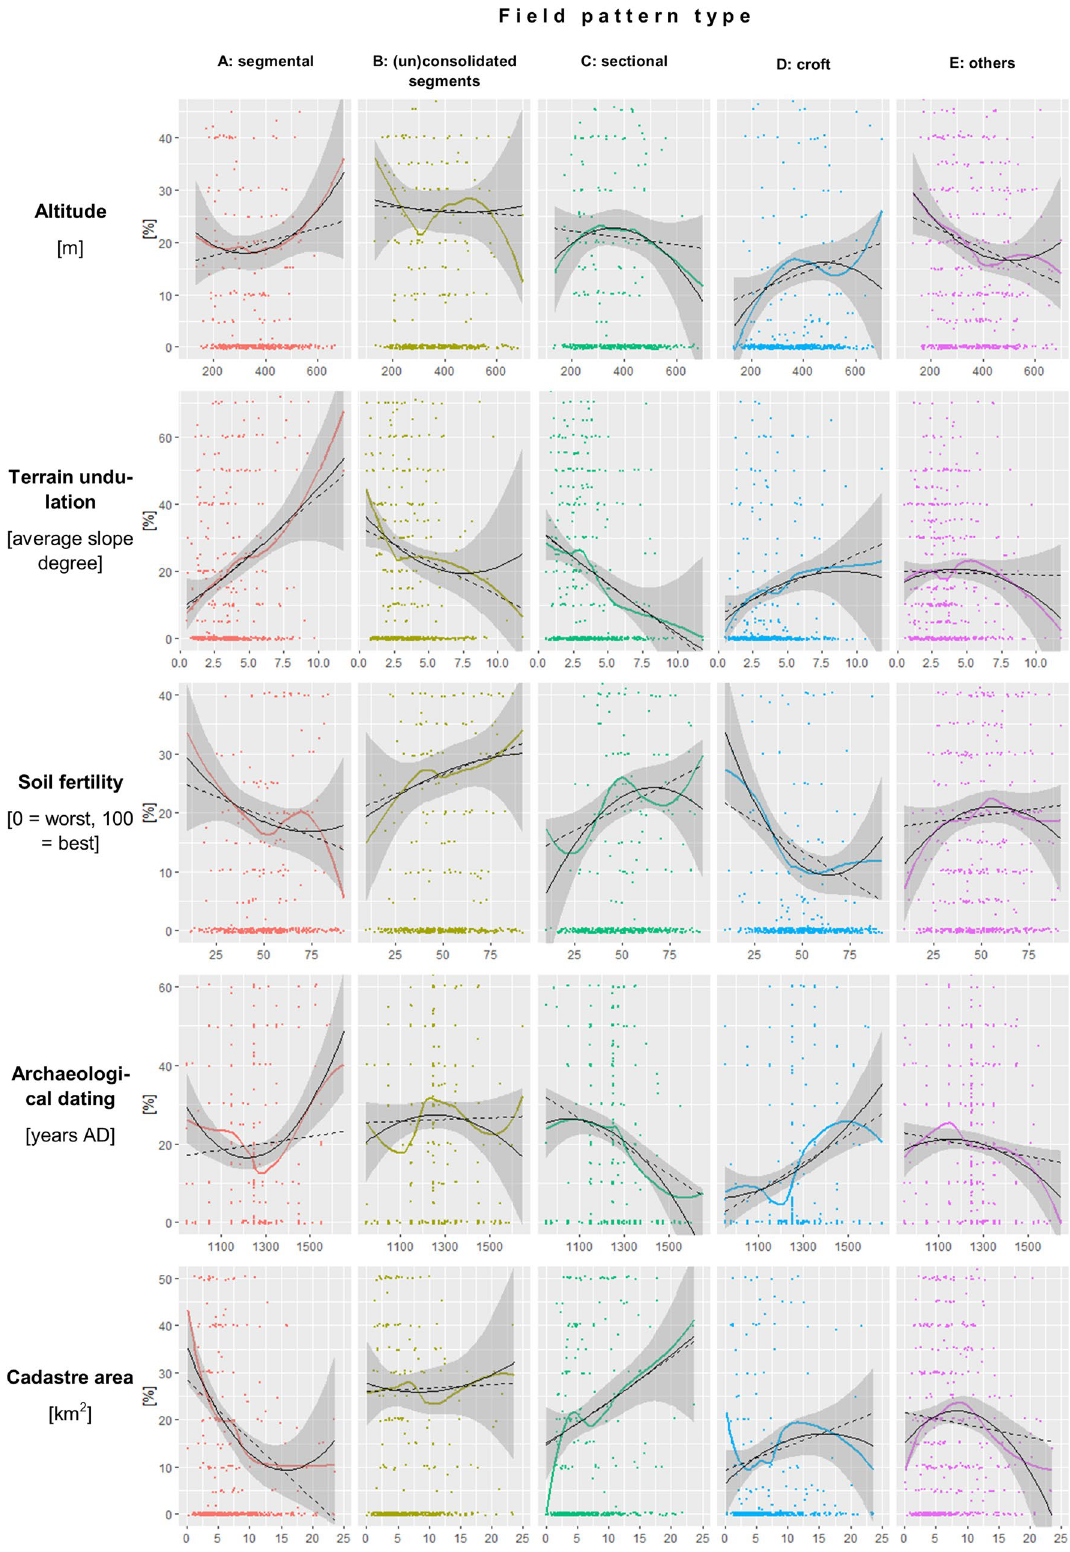
Figure 2. Influence of continuous variables. The percentages refer to the proportion of the specific field pattern type in the examined cadastres. The descriptions of variables and their units of the x-axes are on the left side of the respective